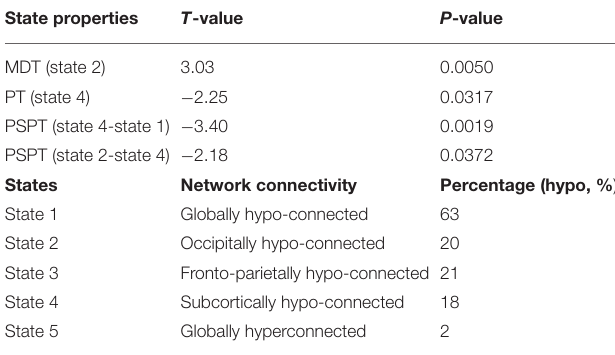
TABLE 2 | Group analysis results of static and dynamic functional connectivity. Functional pairs